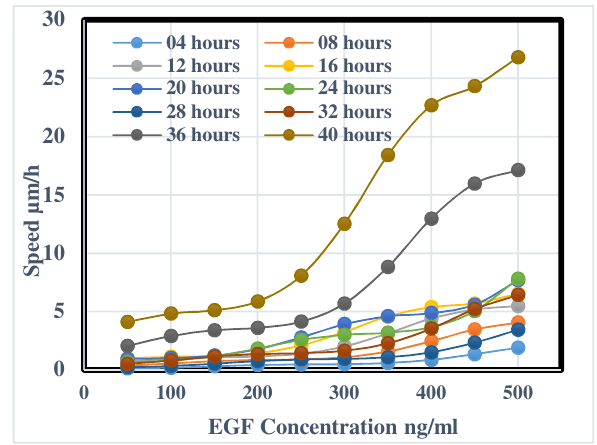
Fig. 10. Radial speed of healing w.r.t the EGF concentration for 10 steps of